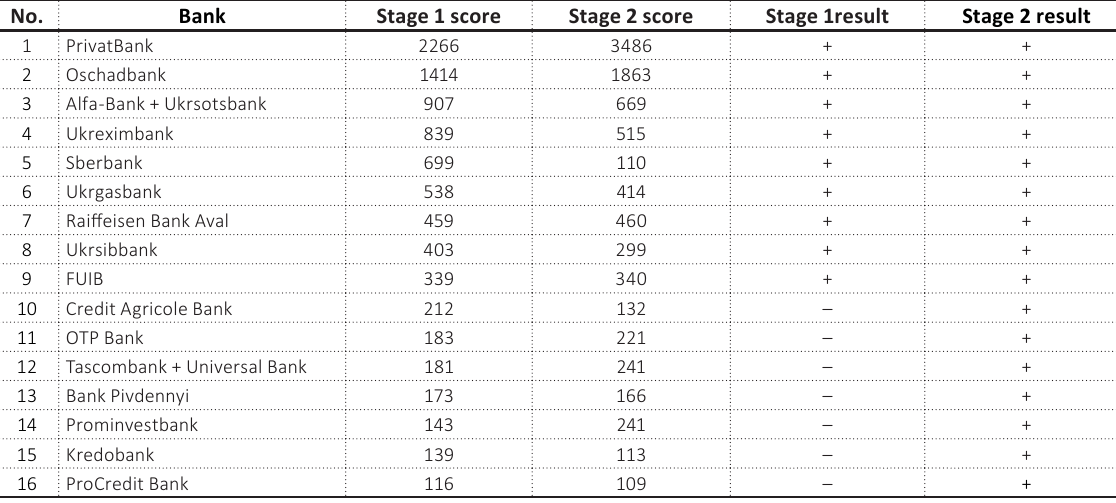
Sources: Authors’ estimation (2019).